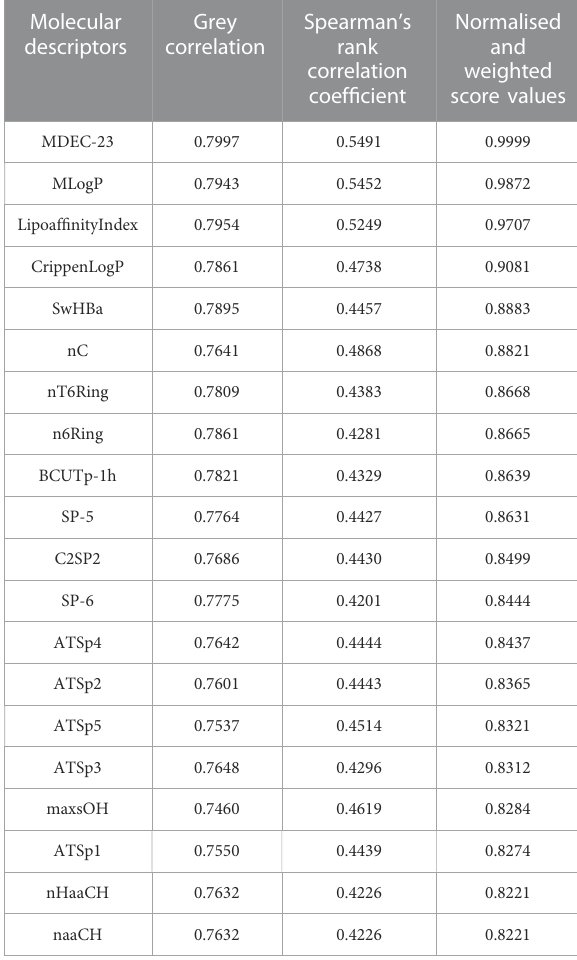
TABLE 2 The 20 most signi fi cant sub-descriptors (i.e., variables) for biological